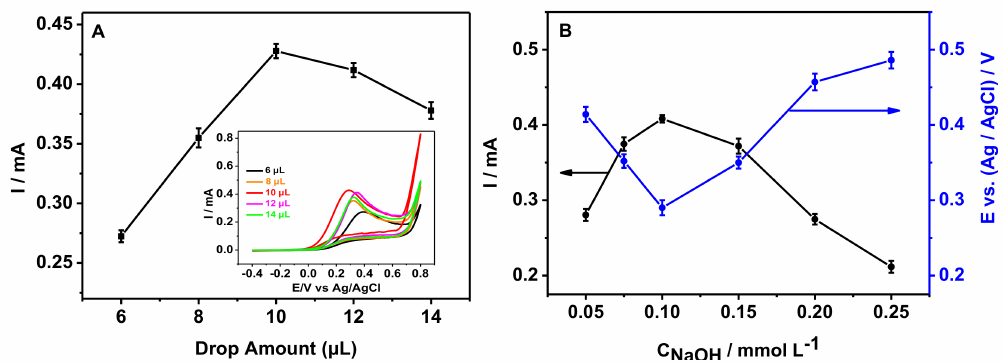
Figure 4. The e ff ect of the drop amount of nano-CuO-400 ( A )inset is the CV curves and the concentration of NaOH ( B ) on the electrochemical behavior of